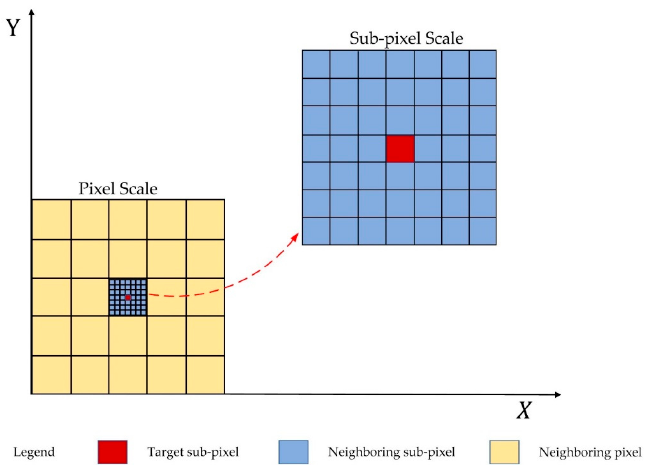
Figure 2. Multispatial neighborhood system.